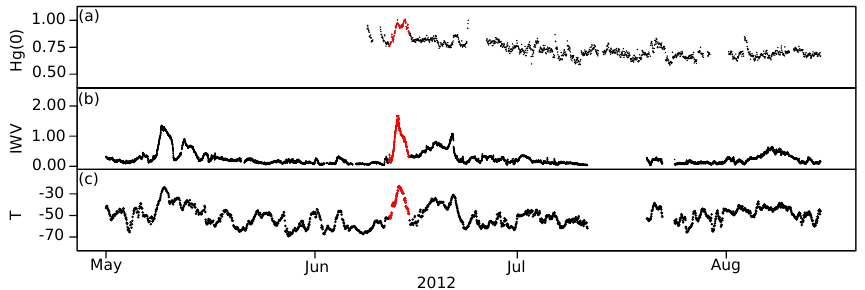
Figure 9. Year 2012 wintertime record of (a) hourly averaged Hg(0) concentrations (in ngm − 3 ) at 500cm above the snow surface, (b) in- tegrated water vapor (IWV, kgm − 2 ), and (c) temperature ( T , ◦ C) at 10m above ground level. Hg(0), temperature, and IWV increased from 12 to 15 June (in red) suggesting transport of moist and warm air masses originating from lower latitudes.